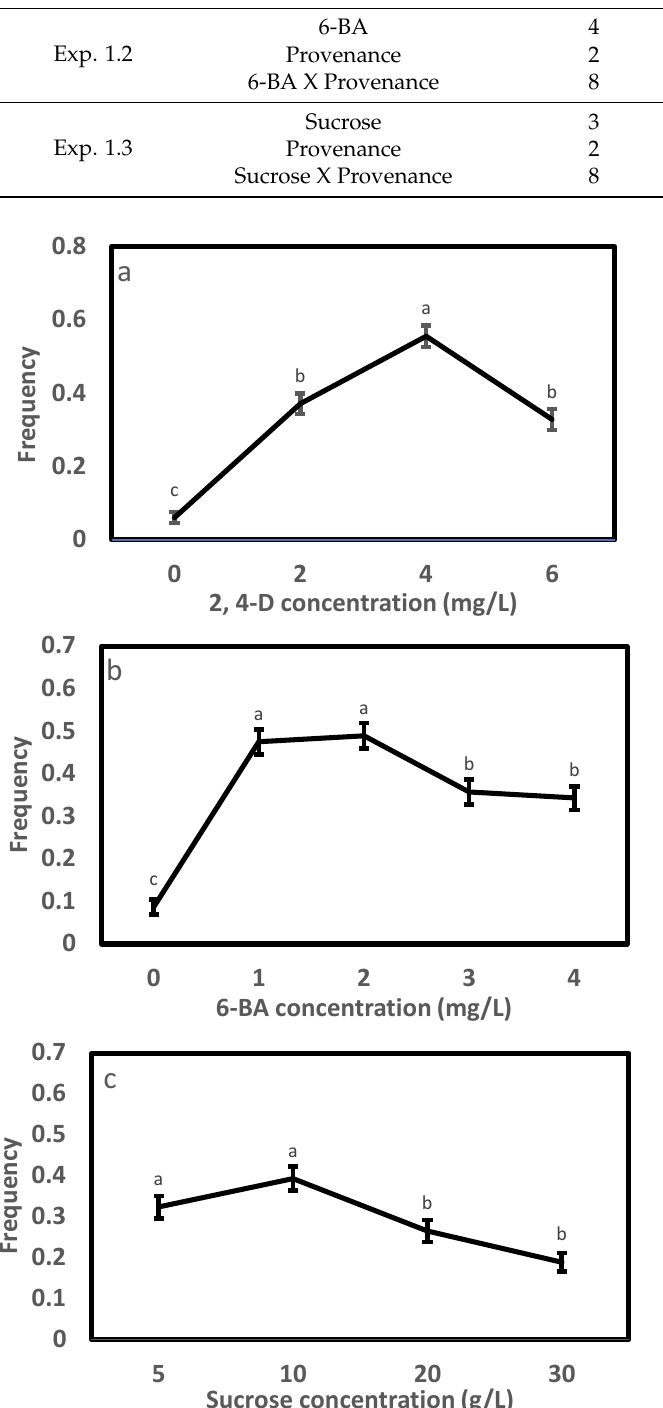
Figure 2. Initiation frequency and standard error by experiment: ( a ) 2,4-D, ( b ) 6-BA and ( c ) sucrose. Note that values with the same letters marked on a panel were statistically